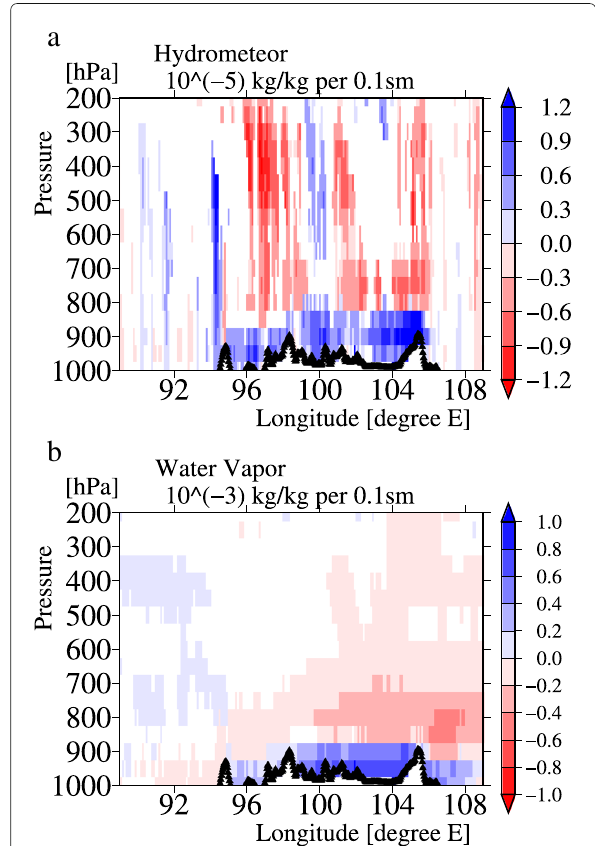
Fig. 8 Longitude-vertical (in pressure coordinates) cross section of PSMsens (slope values) in a hydrometeors and b water vapor along the 18° N latitudinal band. A hydrometeor was defined as the total amount of cloud and precipitations in both the liquid and solid phases. The black triangles indicate the topography along the 18° N latitudinal band. Both horizontal axes in a and b are longitude in °E. The unit of hydrometeors (water vapor) is 10 − 5 kg kg − 1 per 0.1 increase in soil moisture (10 − 3 kg kg − 1 per 0.1 increase in soil